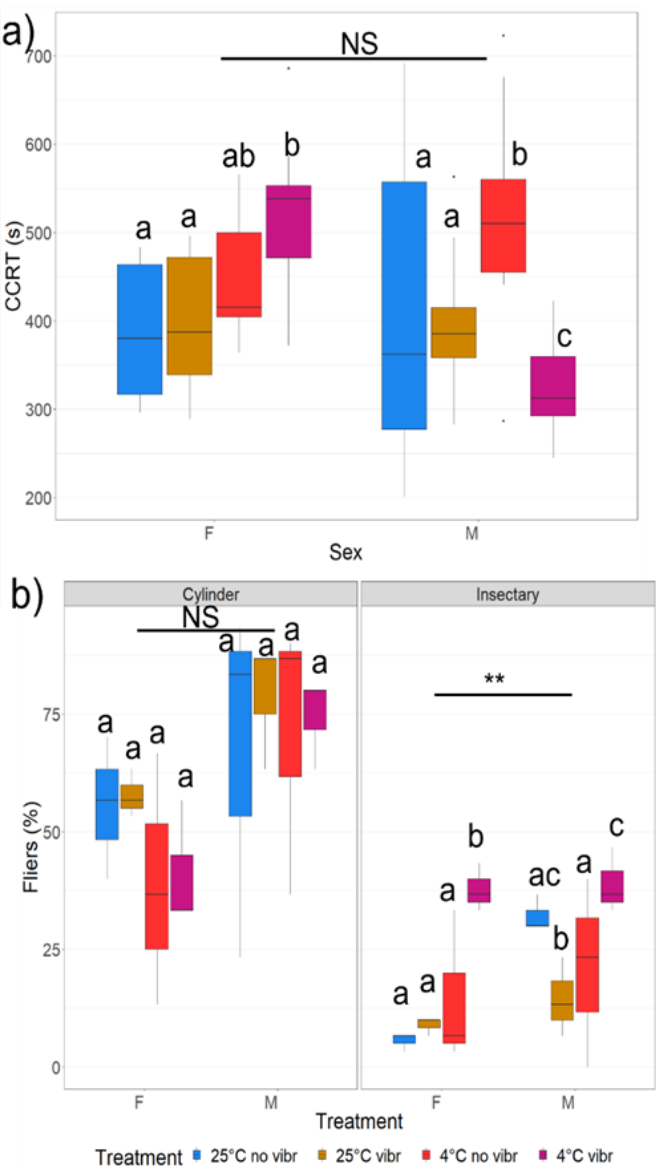
Figure 5. Boxplots indicating ( a ) median CCRT (s) of adult males (M) and females (F) with their upper and lower quantiles and maximum and minimum values (whiskers) after exposure to vibration treatments (25 °C no vibration, 25 °C vibration, 4 °C no vibration and 4 °C vibration); and ( b ) flight performance (median adult male (M) and female (F) fliers (%)) with their upper and lower quantiles and maximum and minimum values (whiskers) at the two different flight tests (cylinder and insectary) after exposure to vibration treatments (25 °C no vibration, 25 °C vibration, 4 °C no vibration and 4 °C vibration). Significant differences between sexes are indicated as: * = p < 0.05, ** = p < 0.001, *** = p < 0.0001, NS = Not significant. Different letters indicate significant differences between treatments.